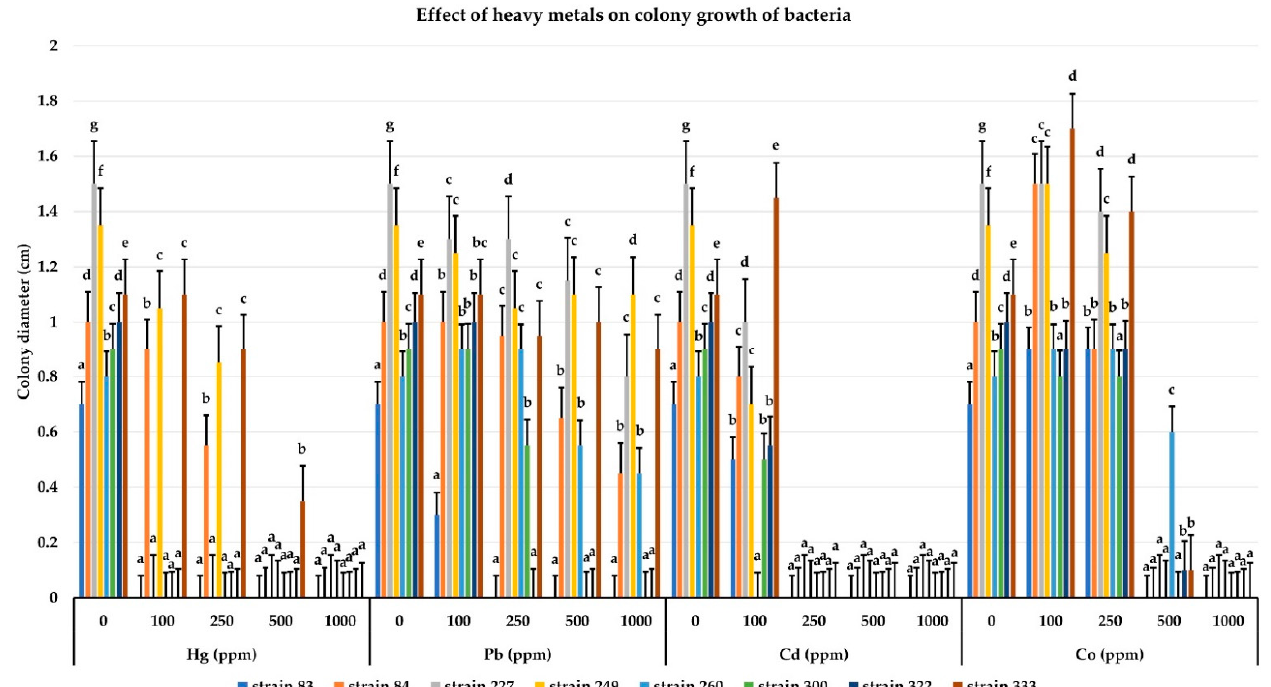
Figure 11. Effects of different concentrations of heavy metals (Hg, Pb, Cd, and Co) on the growth of bacterial strains. The data present the means ± the standard error. Different letters between bars in each group indicate a significant difference at ( p < 0.05) determined by ANOVA with the comparison of means using Tukey’s HSD.